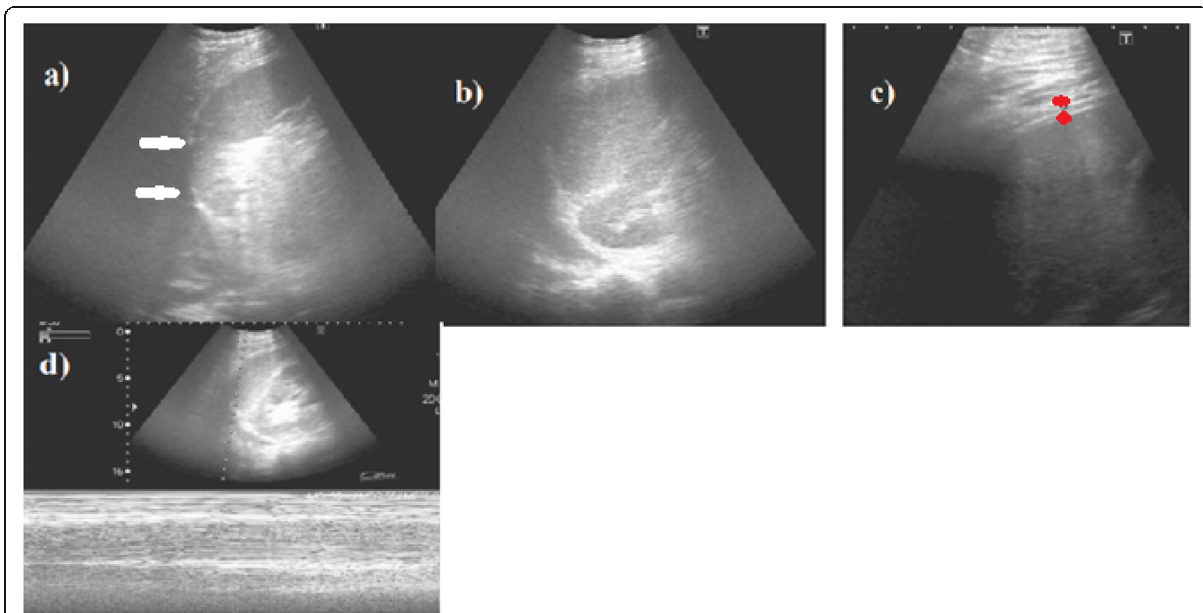
Fig. 3 a - d US images for a 22-year-old male patient presented with an old left hypochondrium stab and was reported to have a left hemidiaphragmatic defect in his CT ( a , b ) US images — intercostal views — showing abnormal shape of the left hemidiaphragm with a defect was seen at the postero-lateral aspect measuring 4 cm in diameter ( a , between the white arrows) with associated mild left-sided pleural effusion. c US image using superficial probe through an intercostal view measuring the thickness of the left hemidiaphragm (2.9 mm between the red dots) with a thickening fraction 15%. d US image in intercostal view showing marked limitation — almost absence — of the Lt. diaphragmatic movement in normal (= 0.3 cm), deep breathing (= 0.5 cm), and in sniff test (= 0.3 cm); these findings were relevant to a left hemidiaphragmatic weakness with a post-traumatic defect